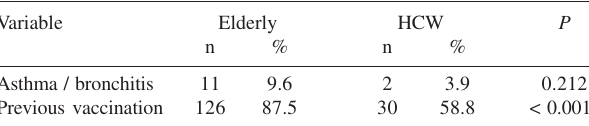
Table 2 - Distribution of individuals vaccinated against